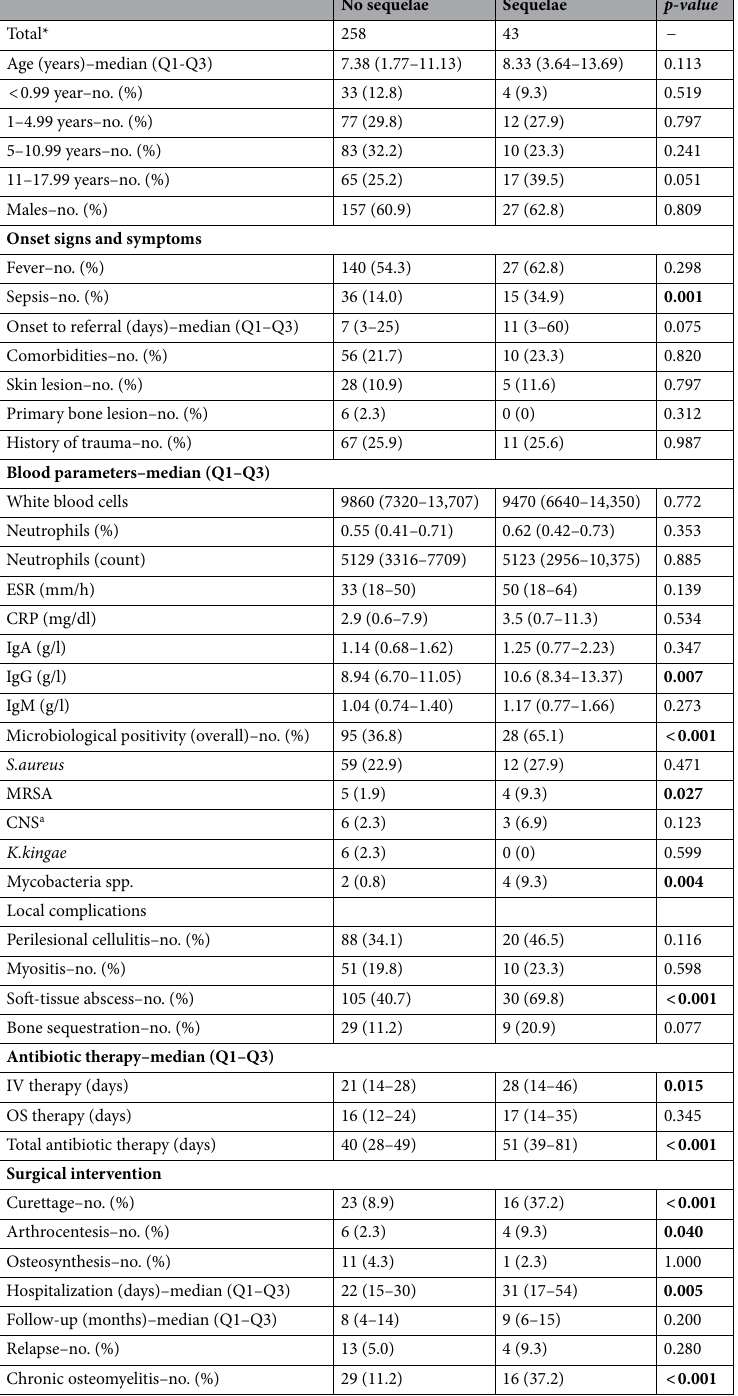
Table 3. Comparison of patients with and without sequelae. *Percentages are calculated accounting for missing values. Significant values are in